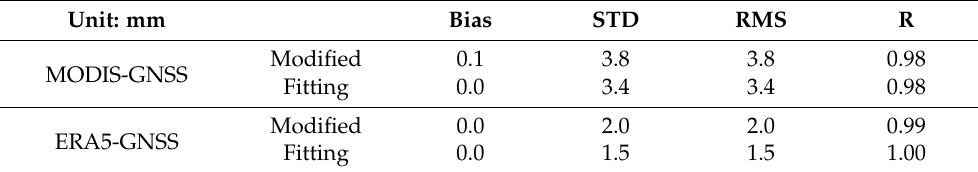
Table 2. Model performance based on annual samples. Unit: mm Bias